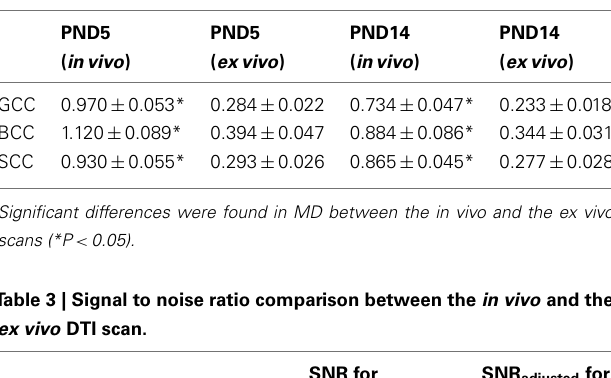
Table 2 | Mean diffusivity (unit: 10 − 3 mm 2 /s) comparison between in vivo and ex vivo scans for PND5 and PND14 scans.